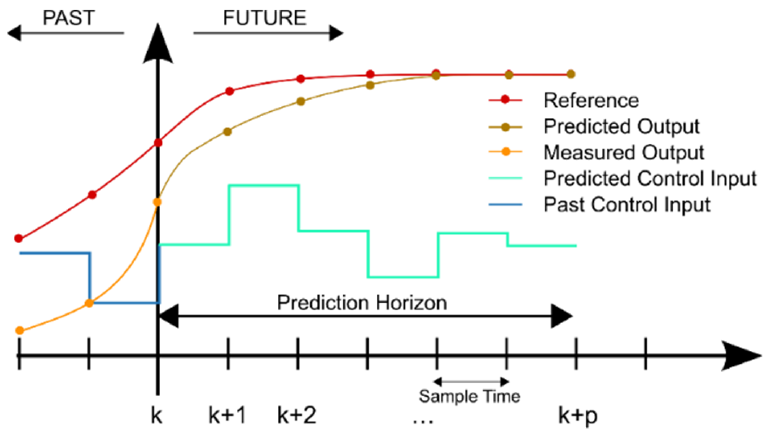
Figure 3. Prediction horizon and predicted control inputs in MPC.